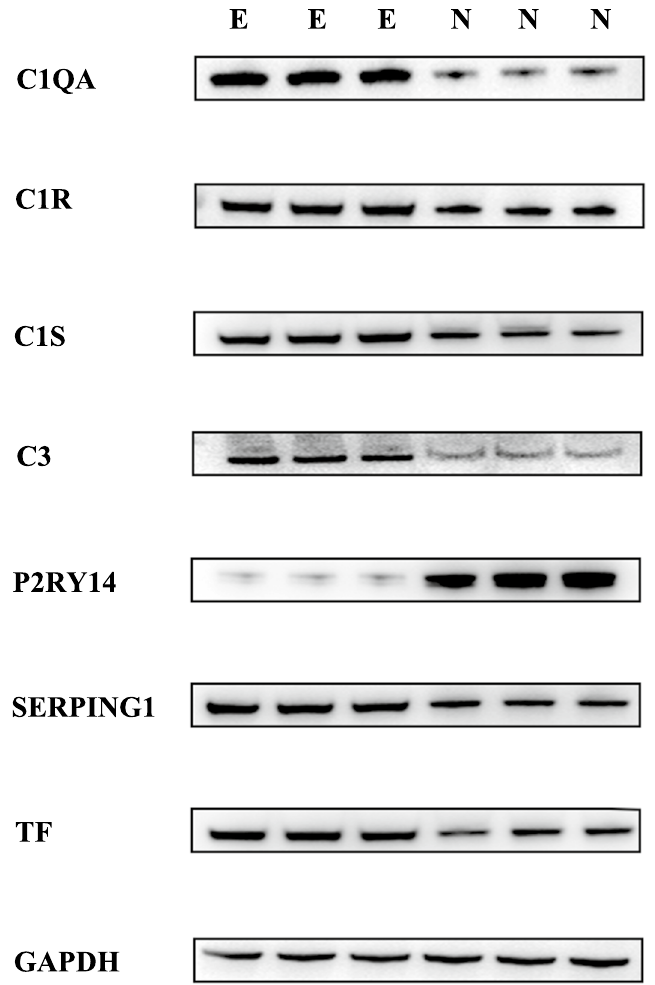
Figure 7. The protein expression of hub genes between groups by WB. The expression of SERPING1, C1S, C1QA, C1R, C3, and TF were up-regulated in EMs group compared with the normal group. The expression of P2RY14 was down-regulated in EMs group compared with the normal